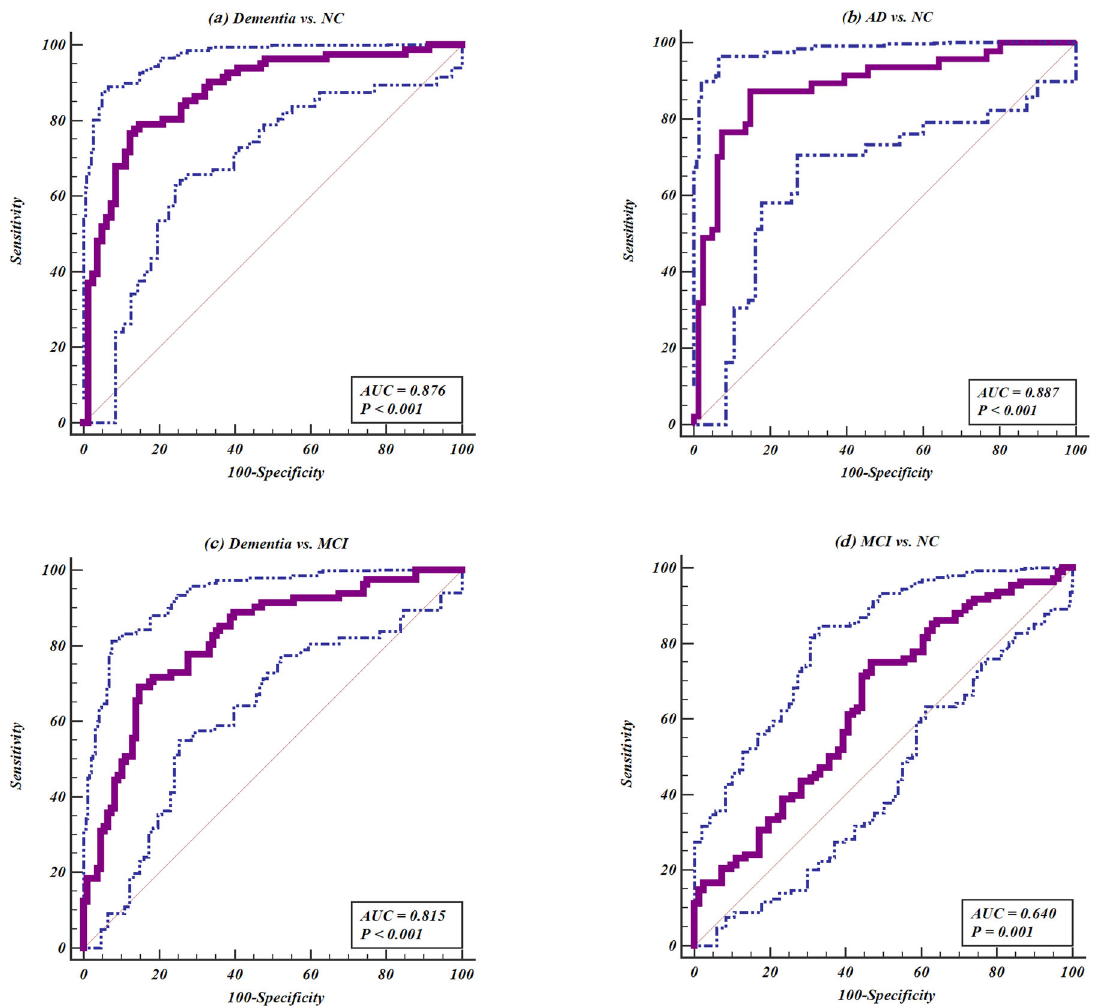
Fig. 5 The ROC curves for the IgG N -glycans (GP8, GP9, and GP14) as diagnostic biomarkers by 5-fold cross-validation using the random forest classi fi er. The ROC curves are represented by purple color lines, while 95% con fi dence intervals (CIs) are represented by blue dotted lines. a Dementia vs. NC, b AD vs. NC, c dementia vs. MCI, and d MCI vs. NC. NC normal cognitive functioning, MCI mild cognitive impairment, AD Alzheimer ’ s